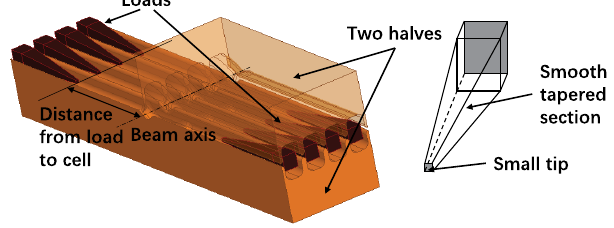
FIG. 16. Geometry of the HOM damping loads.